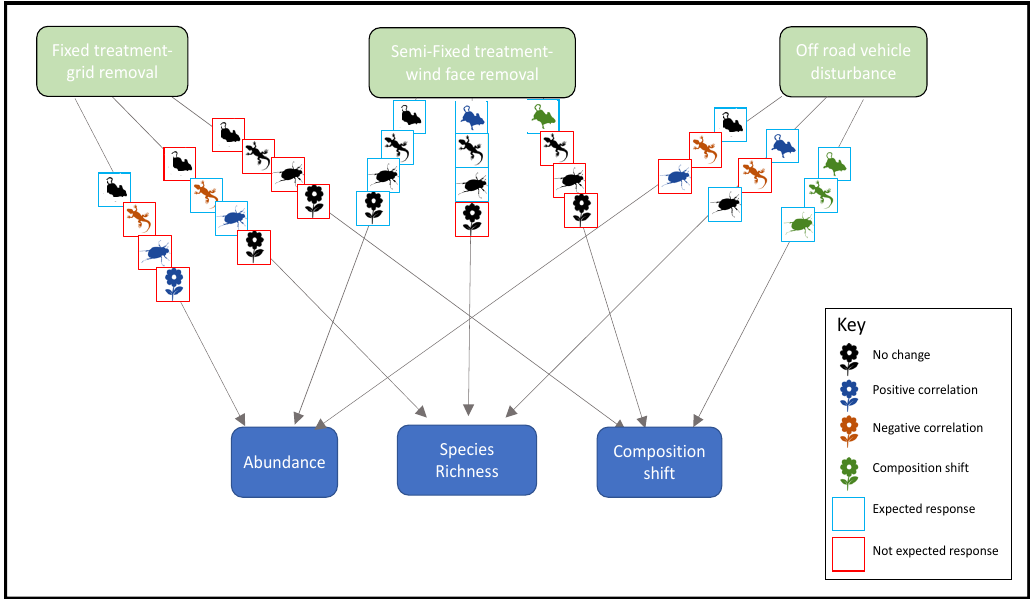
Figure 10. A summary of the responses for three dependent parameters to the three independent treatments, across four different taxa. Note some parameters showed no significant change, which could still be the ‘desired’ response if there was no difference between control and reference dunes. The comparative strengths of the responses are not depicted.